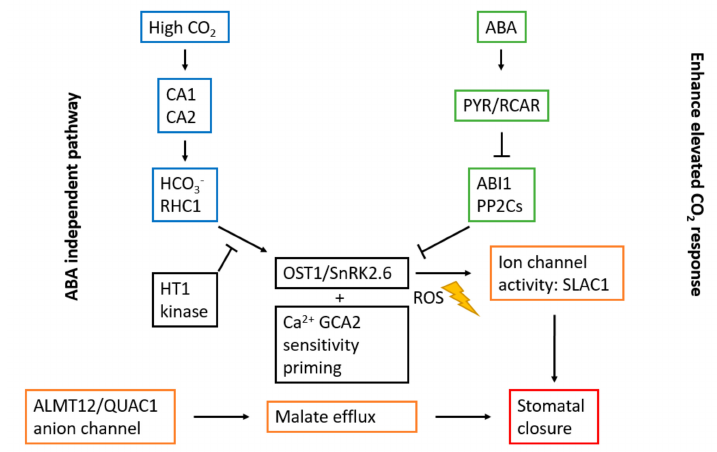
Figure 5. Schematic illustration of the interaction of elevated CO 2 concentration and ABA mediating stomatal movement. CO 2 and ABA signaling unite downstream of OST1 / SnRK2.6 regulating